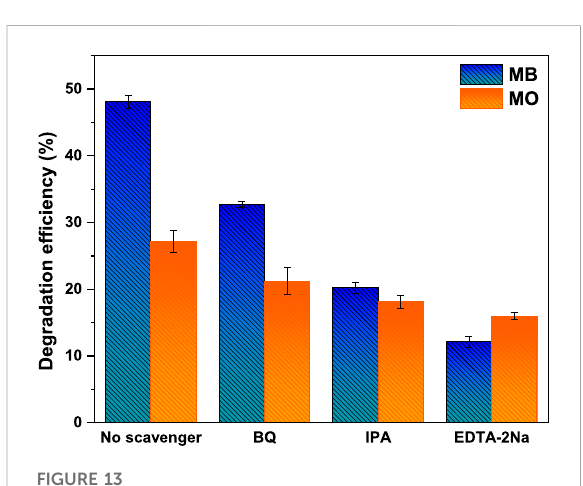
FIGURE 13 The effect of different quenchers on the photocatalytic activity of CoFe 2 O 4 @UiO-66 for degradation of MB and MO